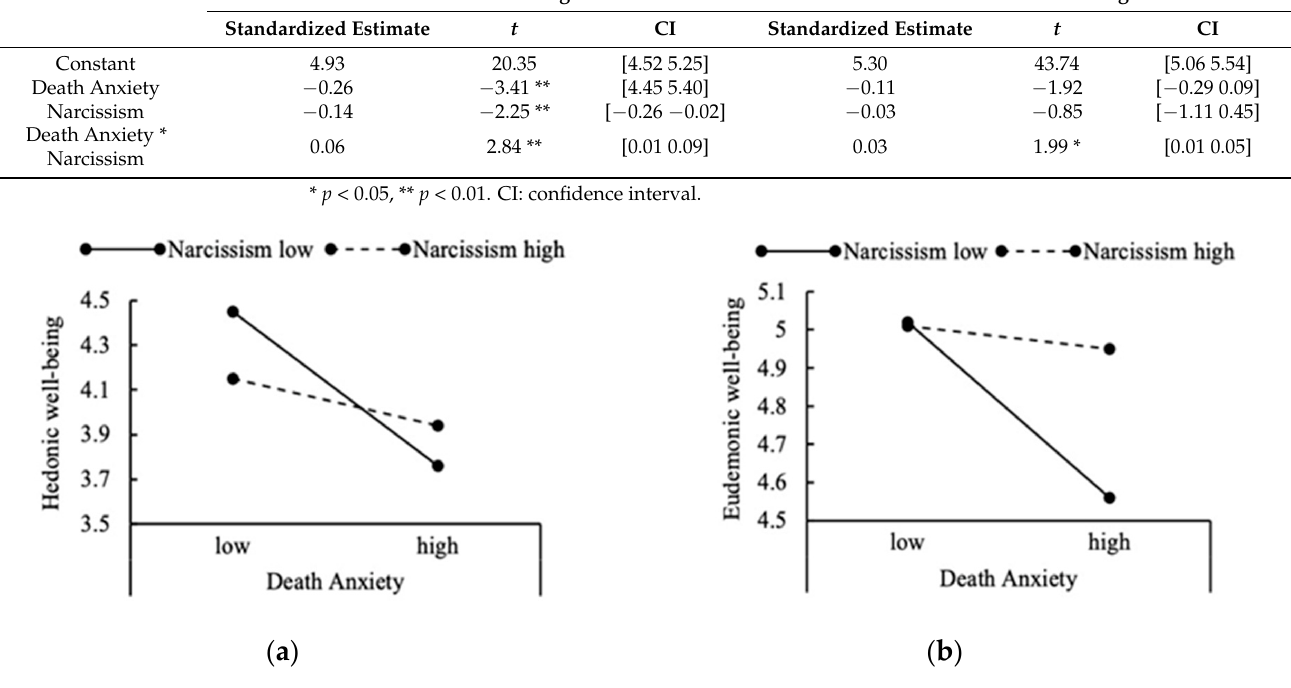
Table 2. Regression Model of Narcissism on Death Anxiety and Well-being ( n = 705). Hedonic Well-Being Eudaimonic Well-Being